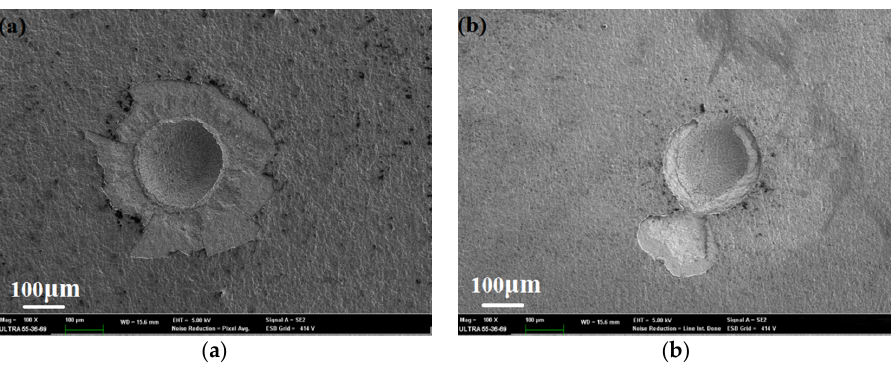
Figure 3. Raman spectra of diamond deposited using different silicon concentrations. A: 0 atom %; B: 0.11 atom %; C: 0.52 atom %; D: 0.98 atom %; E: 1.41 atom % and F: 1.81 atom